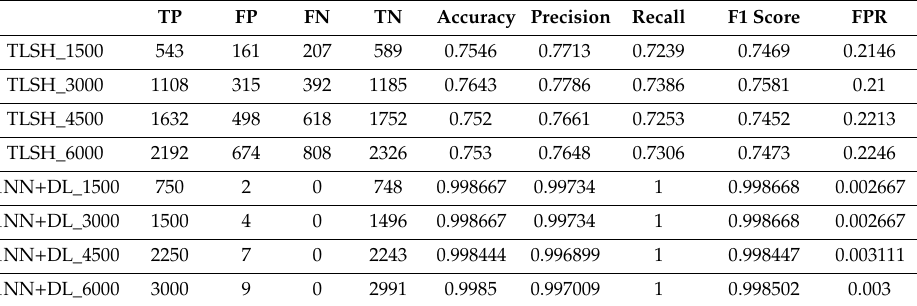
Figure 10. Detection rates. Table 3. Experimental results.